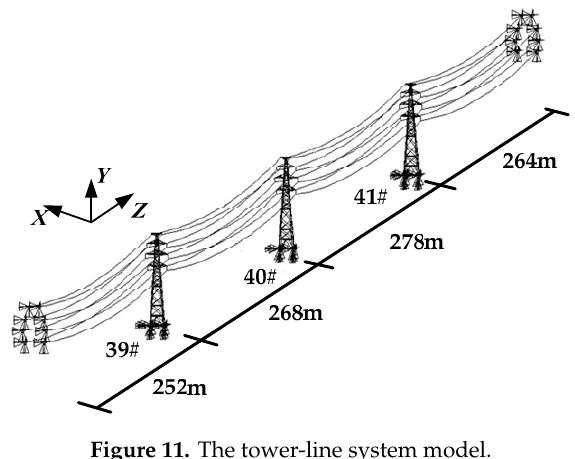
Figure 11. The tower-line system model. Table 2. Technical parameters of rod suspension composite insulator FXBW4-110 / 100.